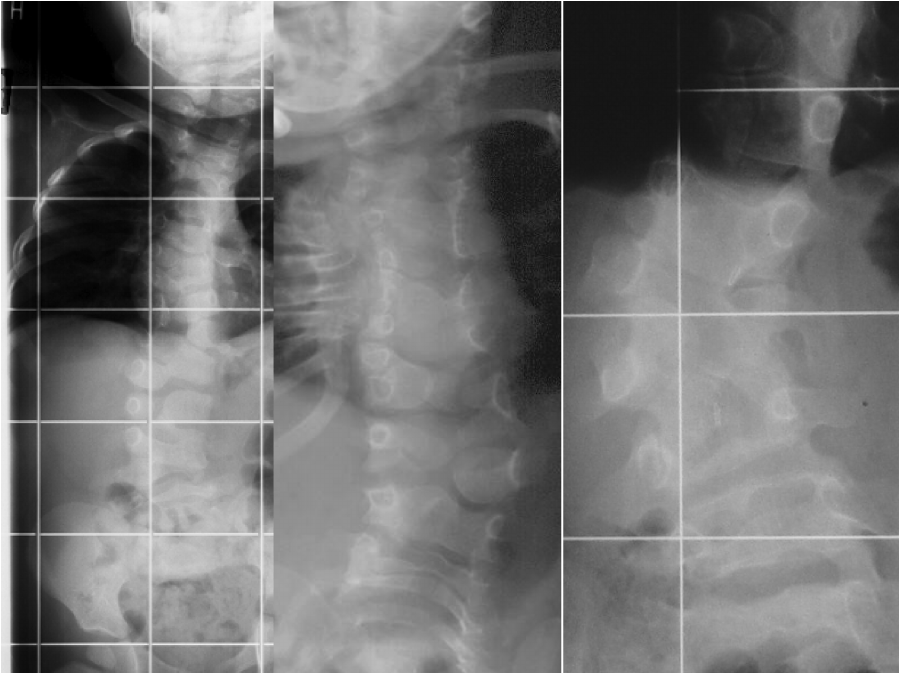
Figure 1 - (a,b,c) Anteroposterior spine radiographs of three patients (a,b) are male patients of 5 and 7 years and c is a female patient of 9 years. All showed extensive malsegmentation of the entire spine (puzzle-like vertebrae) associated with ill-defined cervical spine abnormalities and asymmetry of the thoracic malformation and a variety of different intrinsic rib anomalies including partial fusion, broadening, and bifid